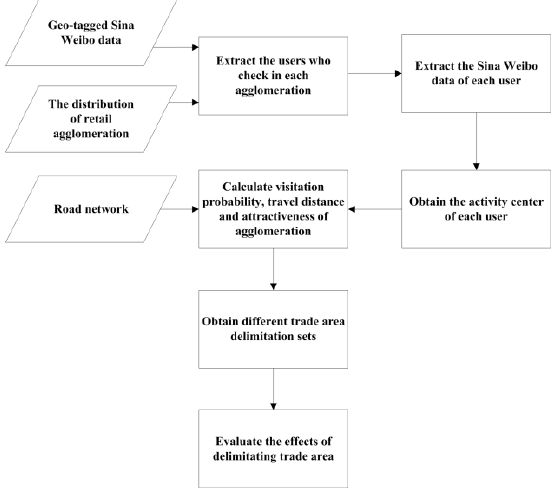
Figure 2. The framework for obtaining samples fit for delimitating trade areas from social media data.